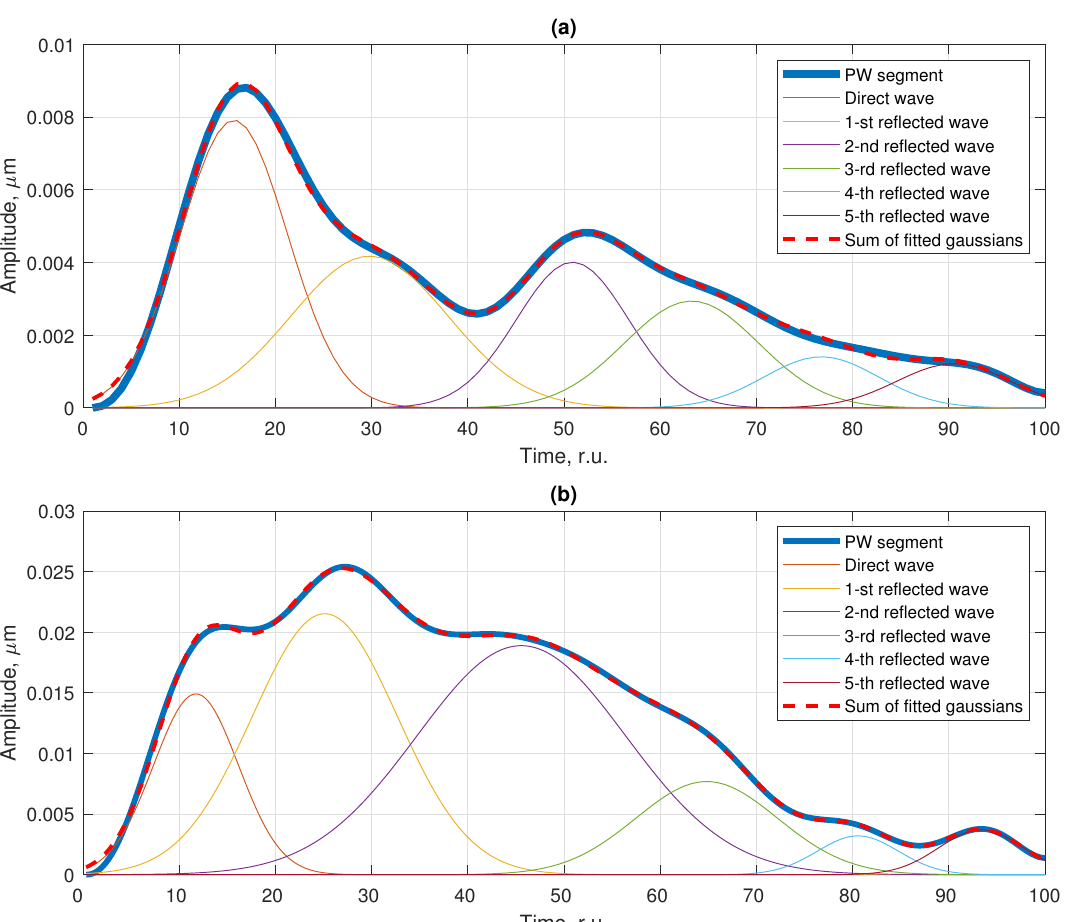
Figure 6. Examples of PW signal intervals measured at radial ( a ) and carotid ( b ) arteries and their approximations by a superposition of Gaussian functions, comprising a superposition into direct and reflected